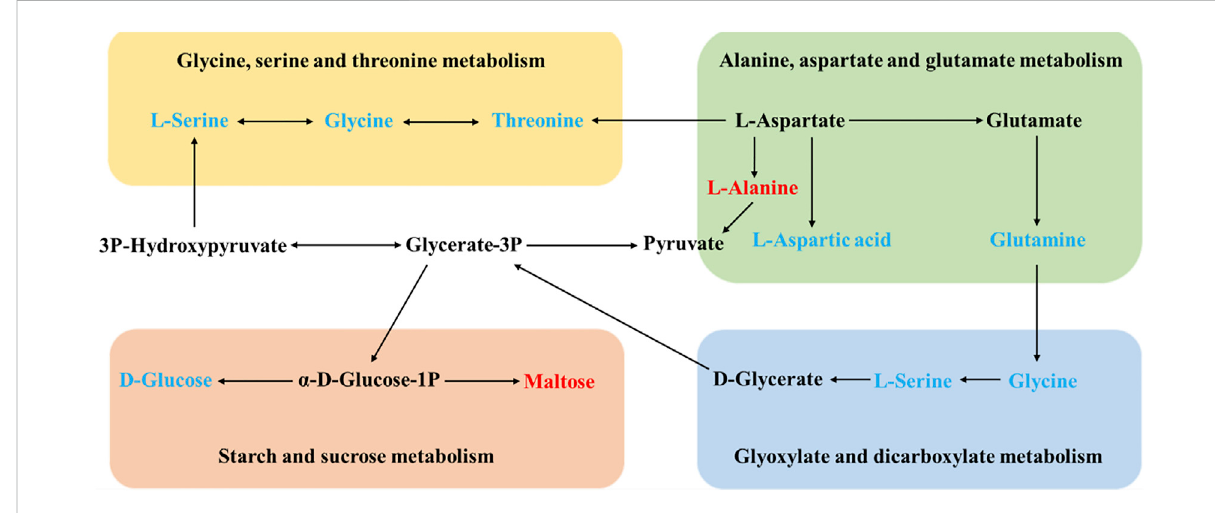
FIGURE 6 Schematic diagram of the metabolic pathways. In the model group, red and blue metabolites represent increased and decreased levels, respectively.